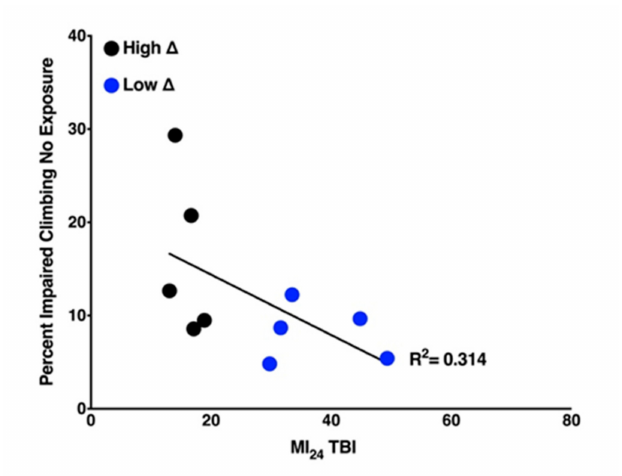
Figure 4. Mortality correlates negatively with climbing activity of uninjured flies. Percent impaired climbing of uninjured RAL lines is plotted against the MI 24 of injured RAL lines from the high ∆ group (black dots) and low ∆ group (blue